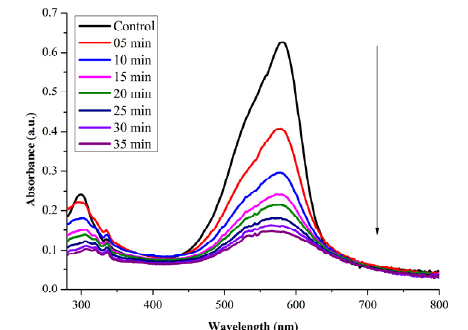
Fig. 6. Spectrum analysis of crystal Violet dye degradation of Pogostemon speciosus SNPs